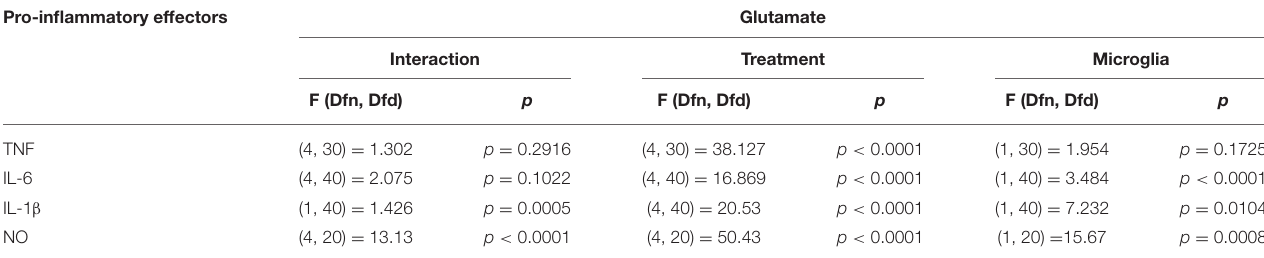
TABLE 2 | Two-way ANOVA details for effect of glutamate on SCM and BM. Pro-inflammatory effectors Glutamate Interaction Treatment